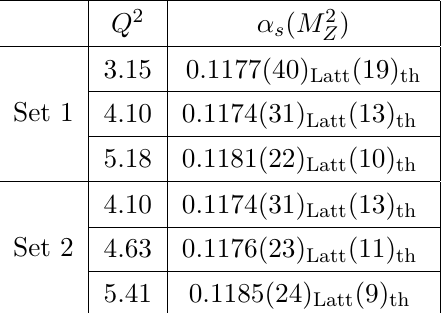
) obtained when the theory uncertainties coming from Z